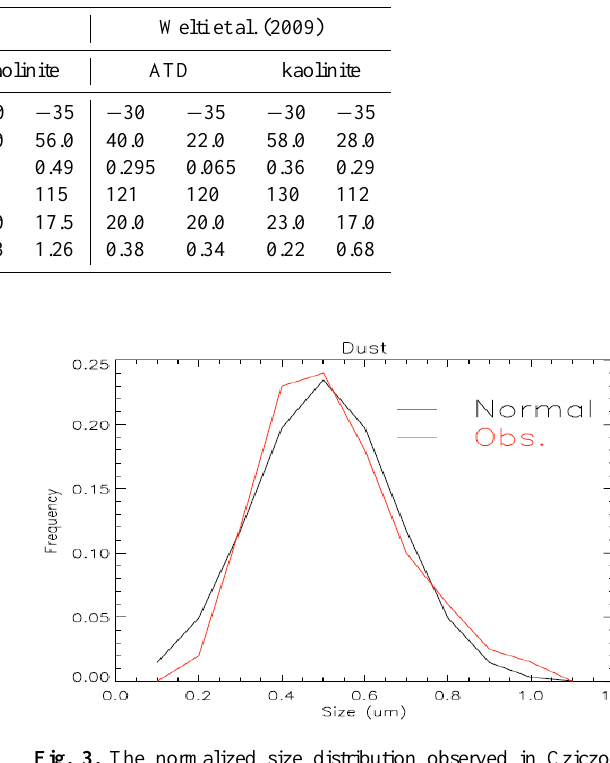
Table 2. Comparison of derived PDF parameters and onset single contact angle ( θ ) calculated at two temperatures and dust types (of size 400nm) with Welti et al. (2009). Possible sources of disagreement are outlined in the text. The data highlighted in bold are used to plot the PDF distribution shown in Fig. 2. The uncertainty errors for µ and σ are ± 3.0 deg and ± 0.04 rad, respectively.